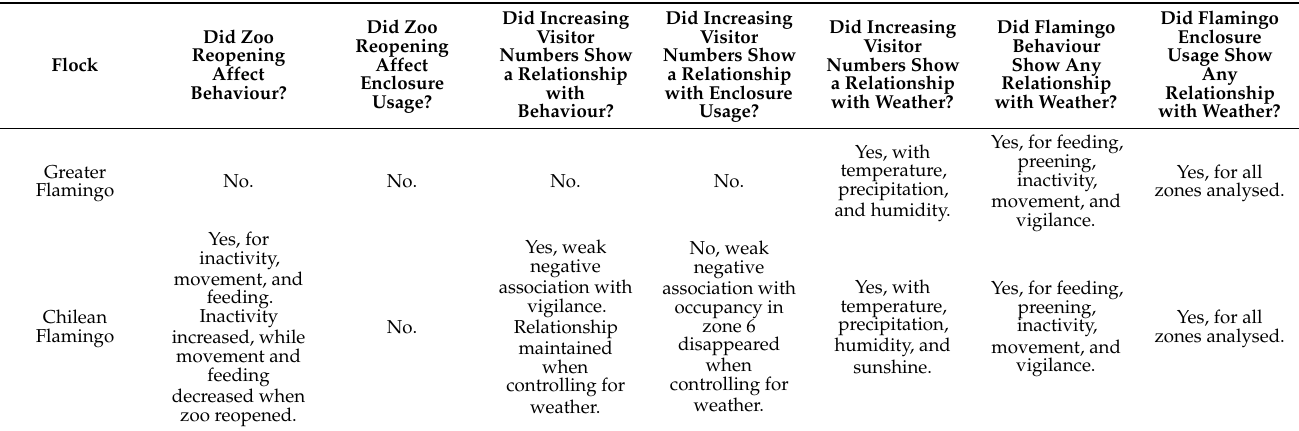
Table 4. Overall summary of behavioural findings in relation to visitors and